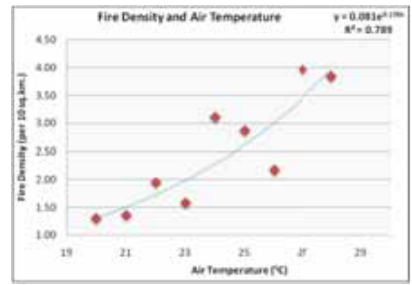
Figure 4: Forest fire density and Air Temp The map represents probable increase i increase in Southern Chhattisgarh may b compare to the other areas and consists in districts.